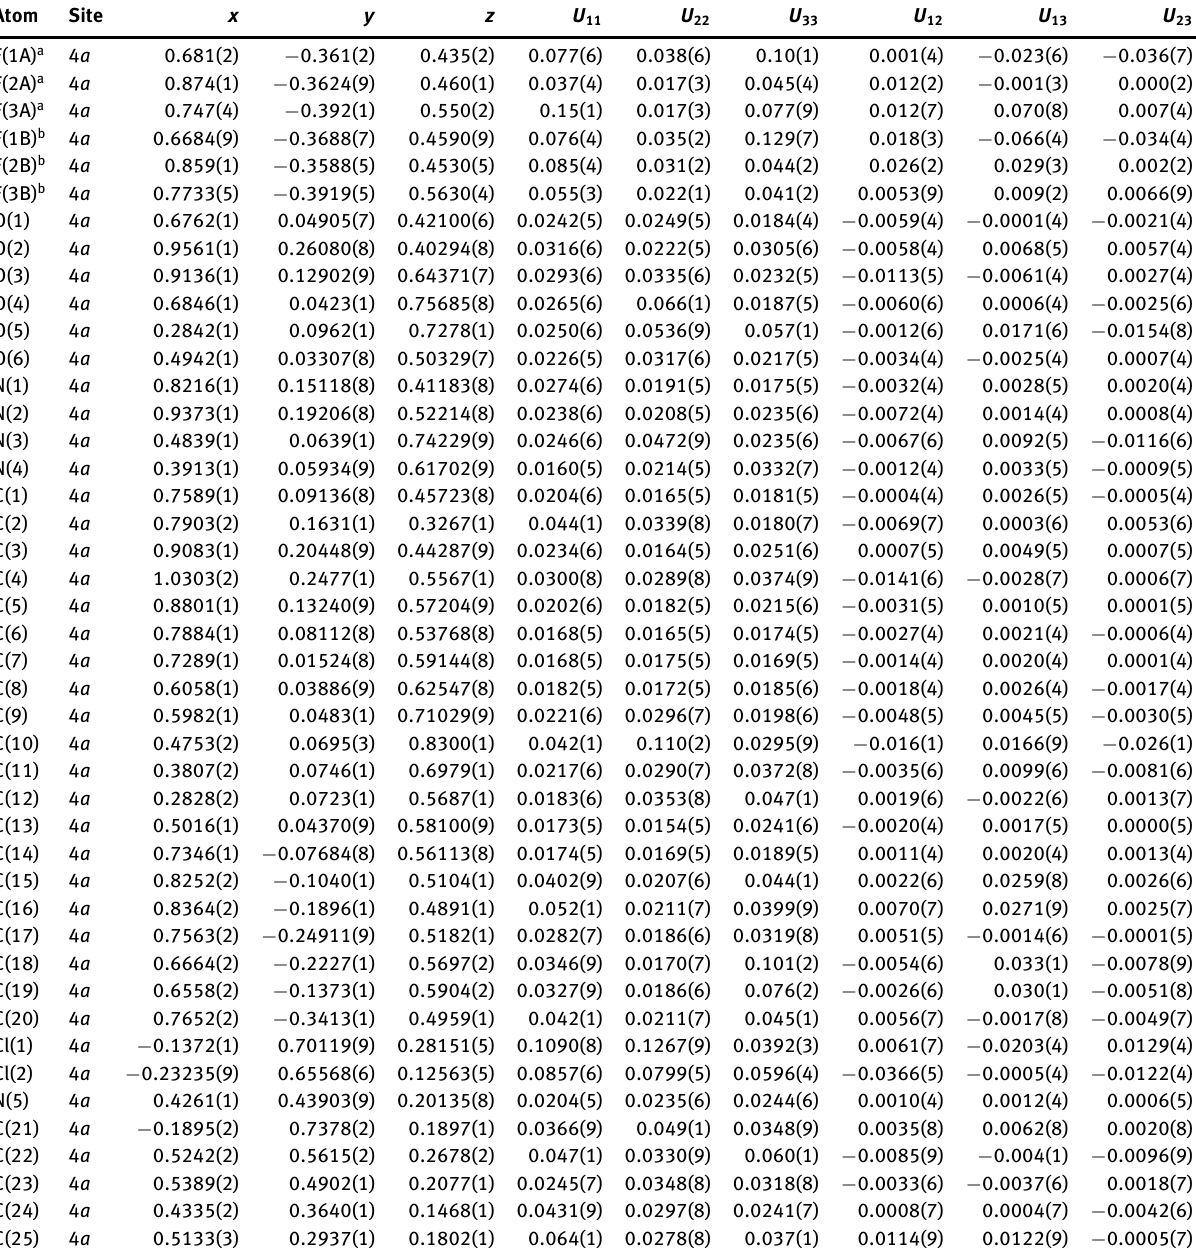
Table 3: Atomic displacement parameters (Å 2